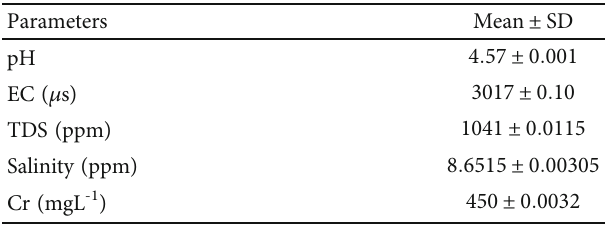
Table 3: Electroplating wastewater physicochemical